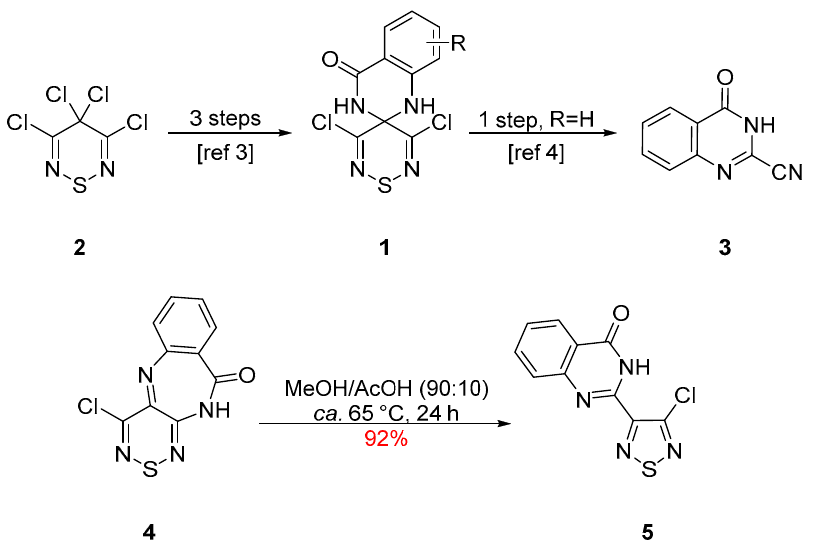
Scheme 1. Synthesis of spirocycles 1 and quinazolinone 3 and isolation of thiadiazole 5 from diazepine 4 .